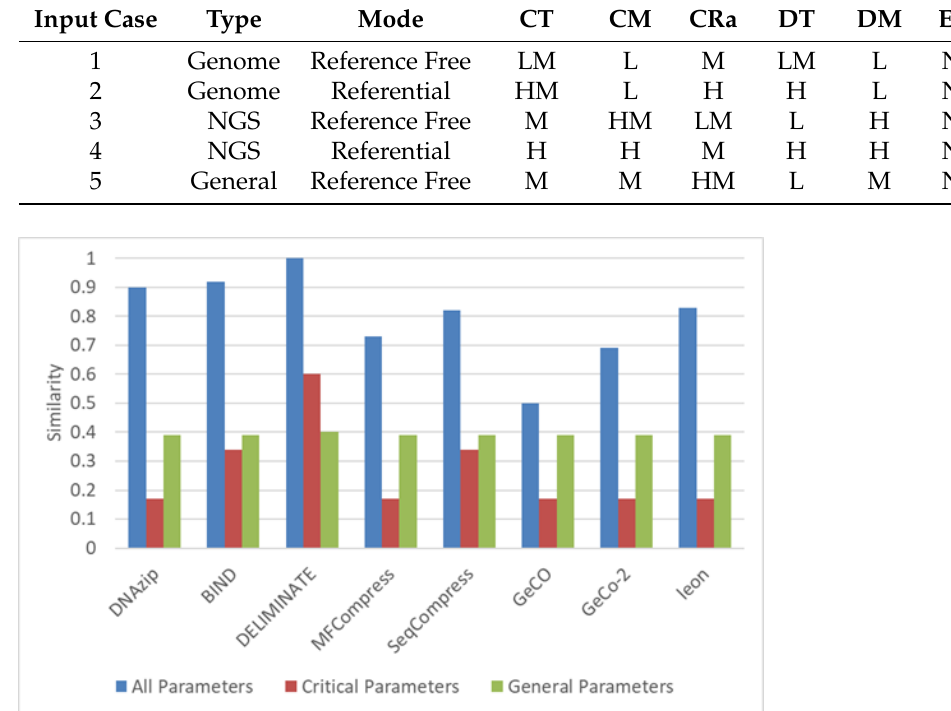
Table 5. Five input cases used to validate the proposed framework. H, M, and L mean high, moderate, and low, respectively.